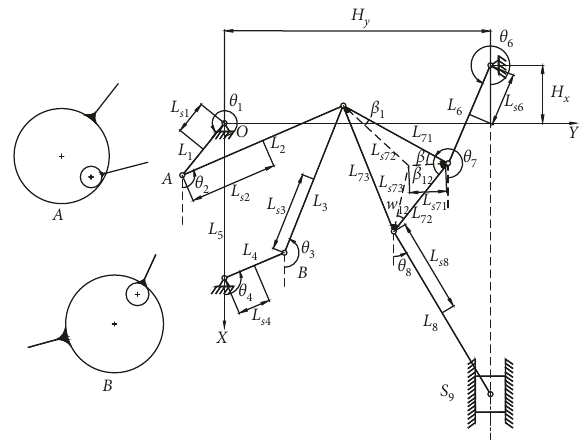
Figure 2: Structure diagram of 2-DOF nine-bar mechanism with revolute